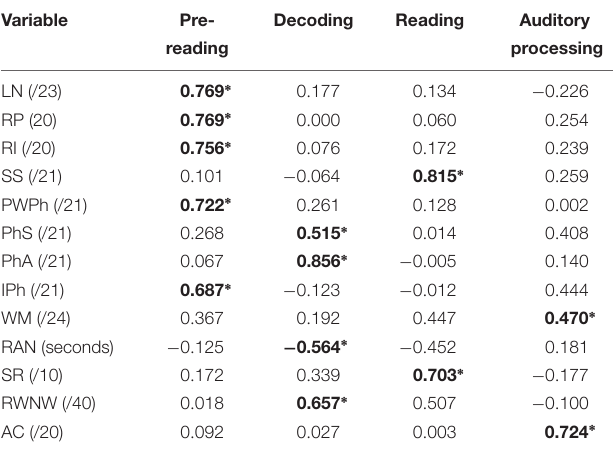
TABLE 4 | Rotated factor loadings in PCA for the four components.